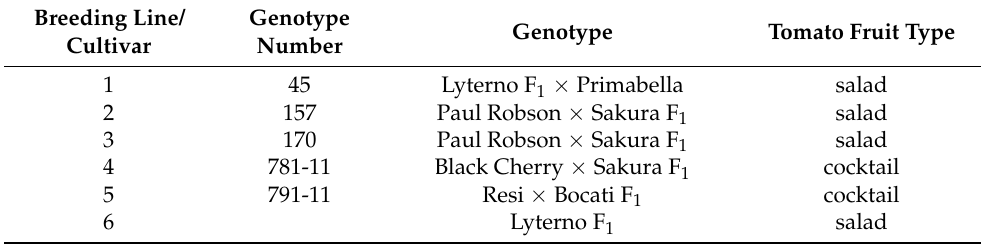
Table 1. Breeding lines and the cultivar used in this study. Breeding